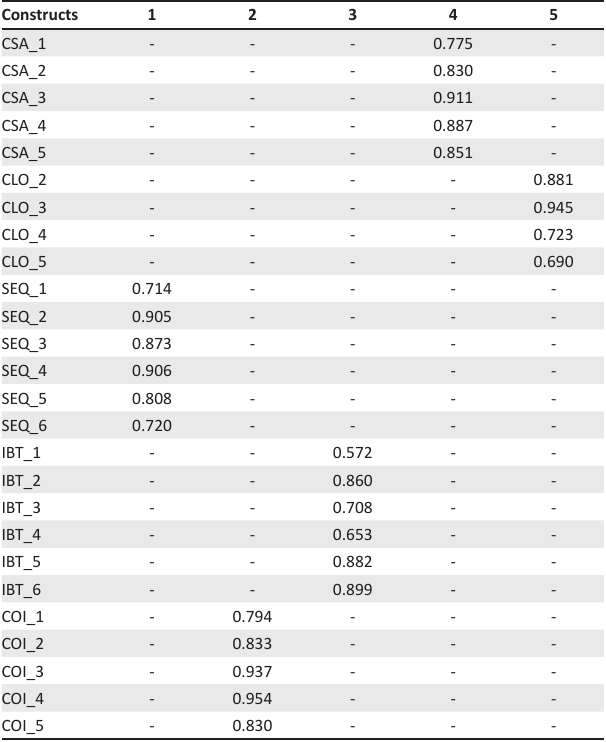
TABLE 5: Pattern matrix of factor